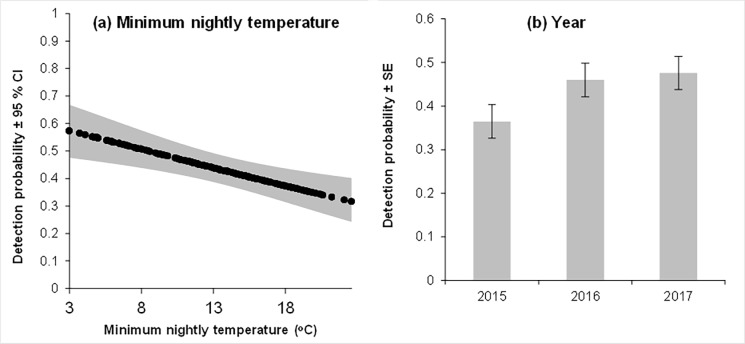
The relationship between modelled values of ρ (detection probability) for koalas and (A) minimum nightly temperature (when year is held constant) and (B) year (when minimum nightly temperature is held at its mean for each respective year).